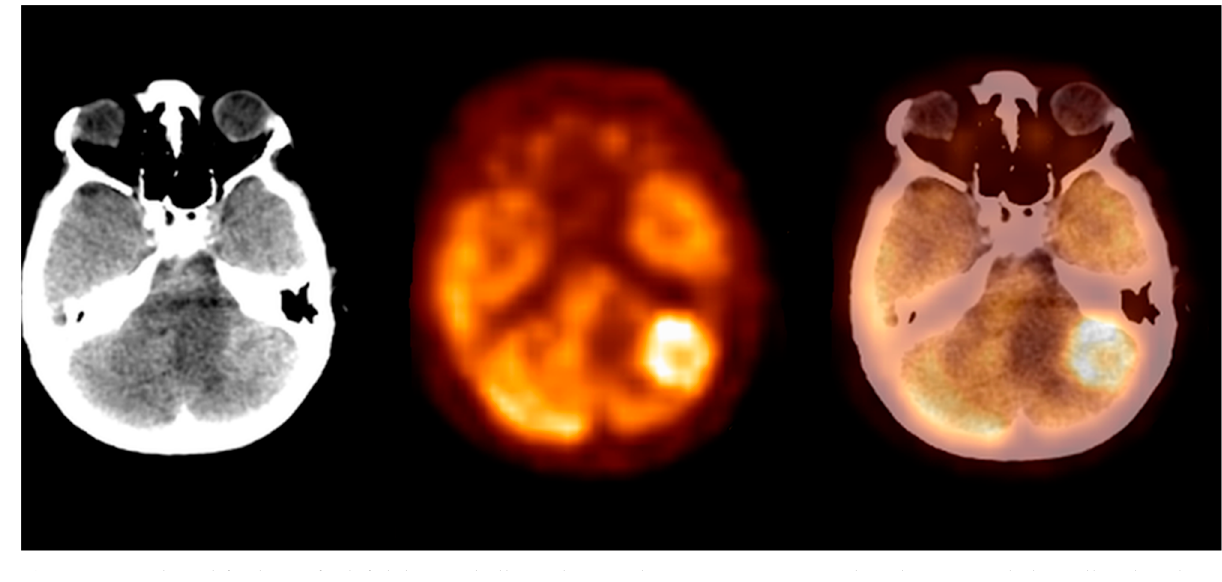
Figure 6. Incidental finding of a left lobe cerebellum abnormal mass, consistent with unknown and clinically silent lung cancer solitary metastatic lesion (source: original figure). Description: axial view of the brain and torso [ 18 F]FDG PET/CT over the cerebellum—low-dose CT ( left -hand side image), PET ( middle image), and PET/CT fusion ( right -hand side image).